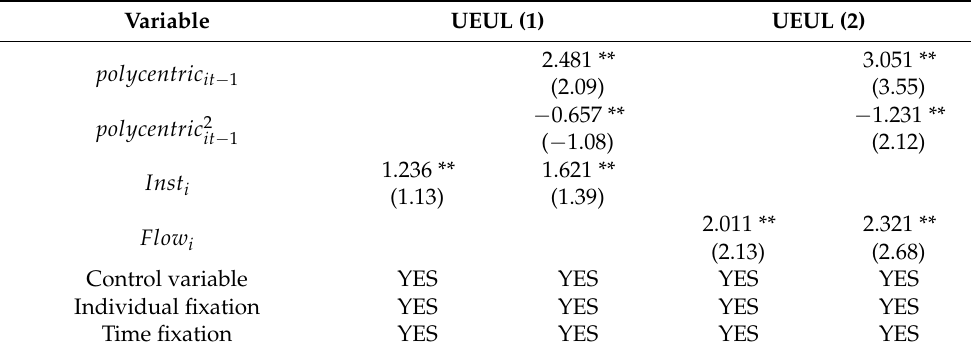
Table 7. Test of mediating effect of polycentric spatial structure on